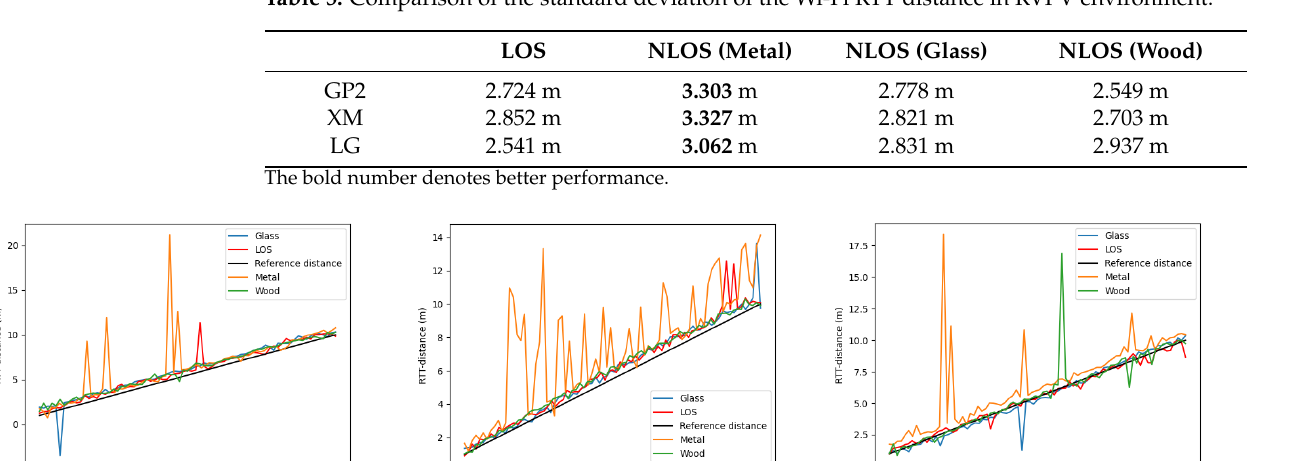
Table 5. Comparison of the standard deviation of the Wi-Fi RTT distance in RVPV environment.